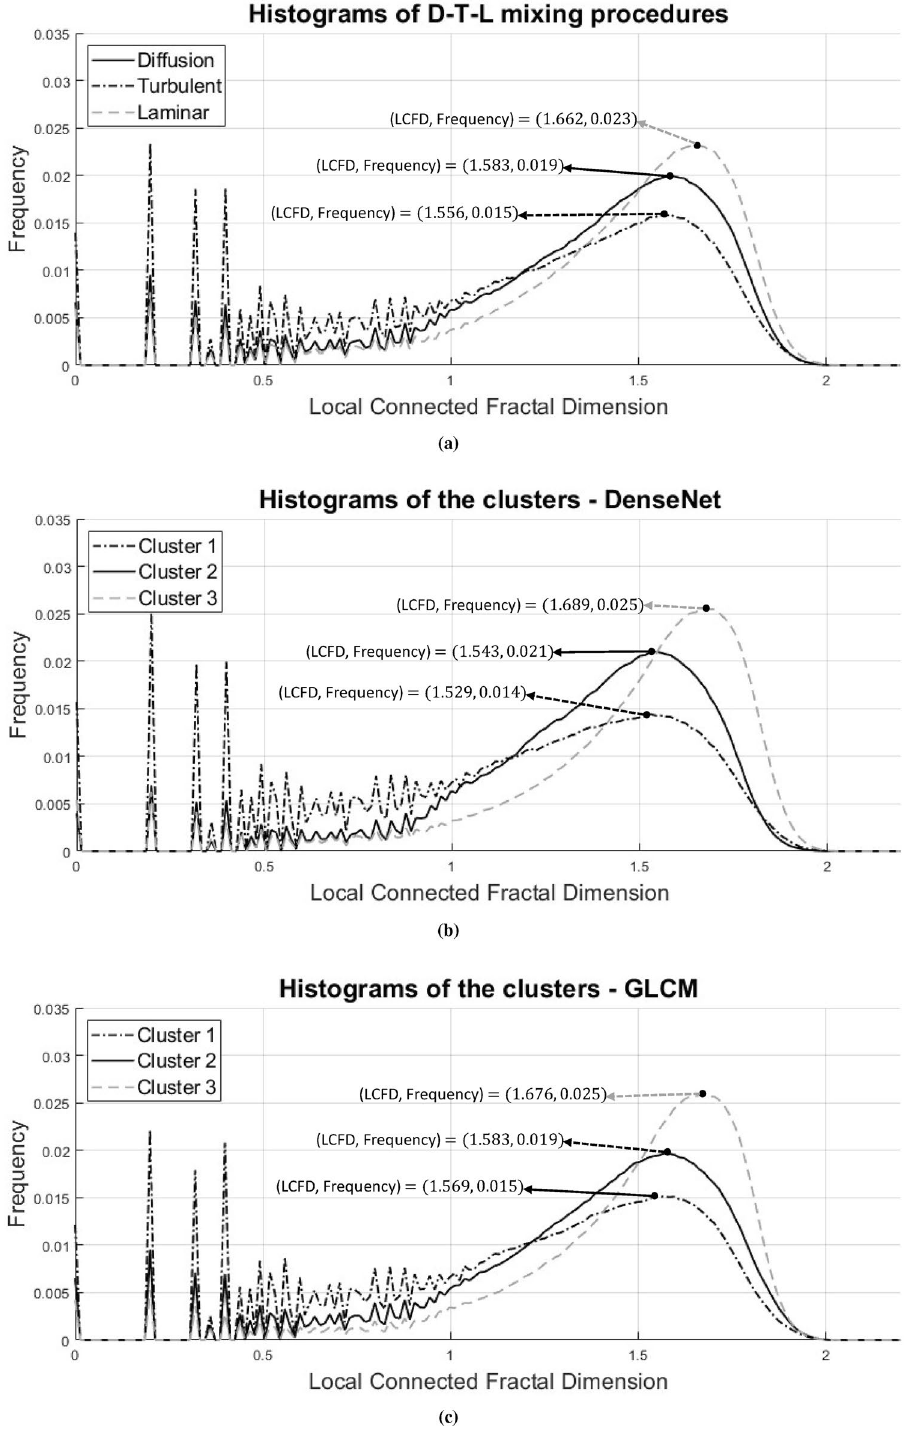
Figure 5. Average LCFD histograms of the full texture patch database. ( a ) Average LCFD histograms of the D, T and L mixing procedures. ( b ) Average LCFD histograms of the clusters determined by deep learning approach. ( c ) Average LCFD histograms of the GLCM